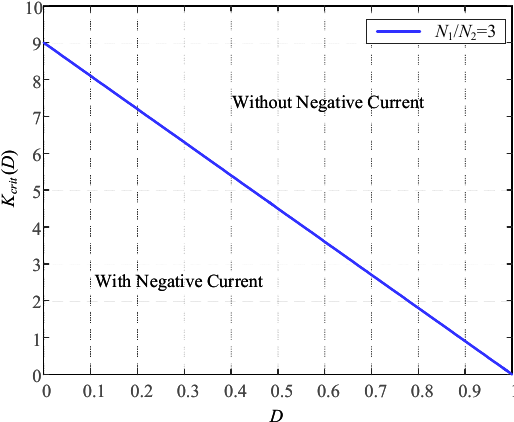
Figure 10. Equivalent model for the coupling inductor under DC analysis. Figure 11. Boundary curve for L m operating mode.